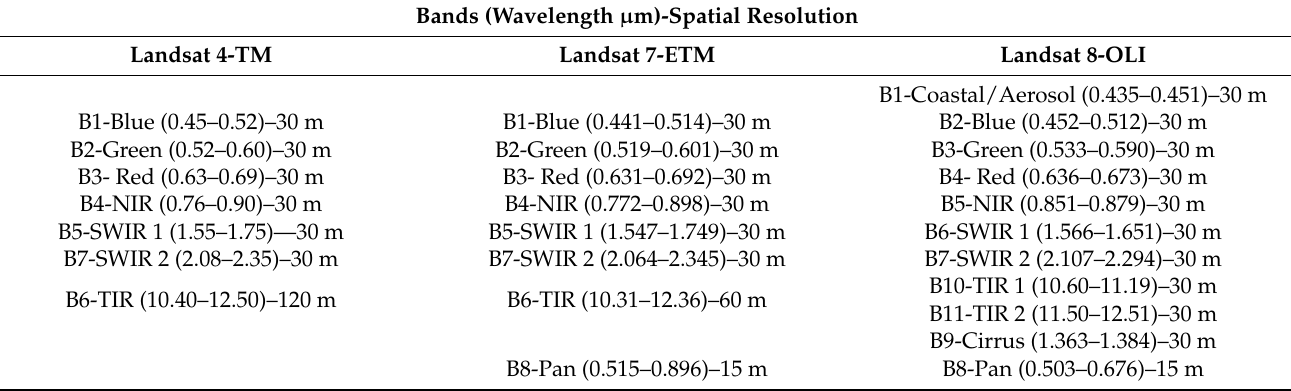
Table 1. Spectral and Spatial characteristics of the Landsat images used in this study. Bands (Wavelength µ m)-Spatial